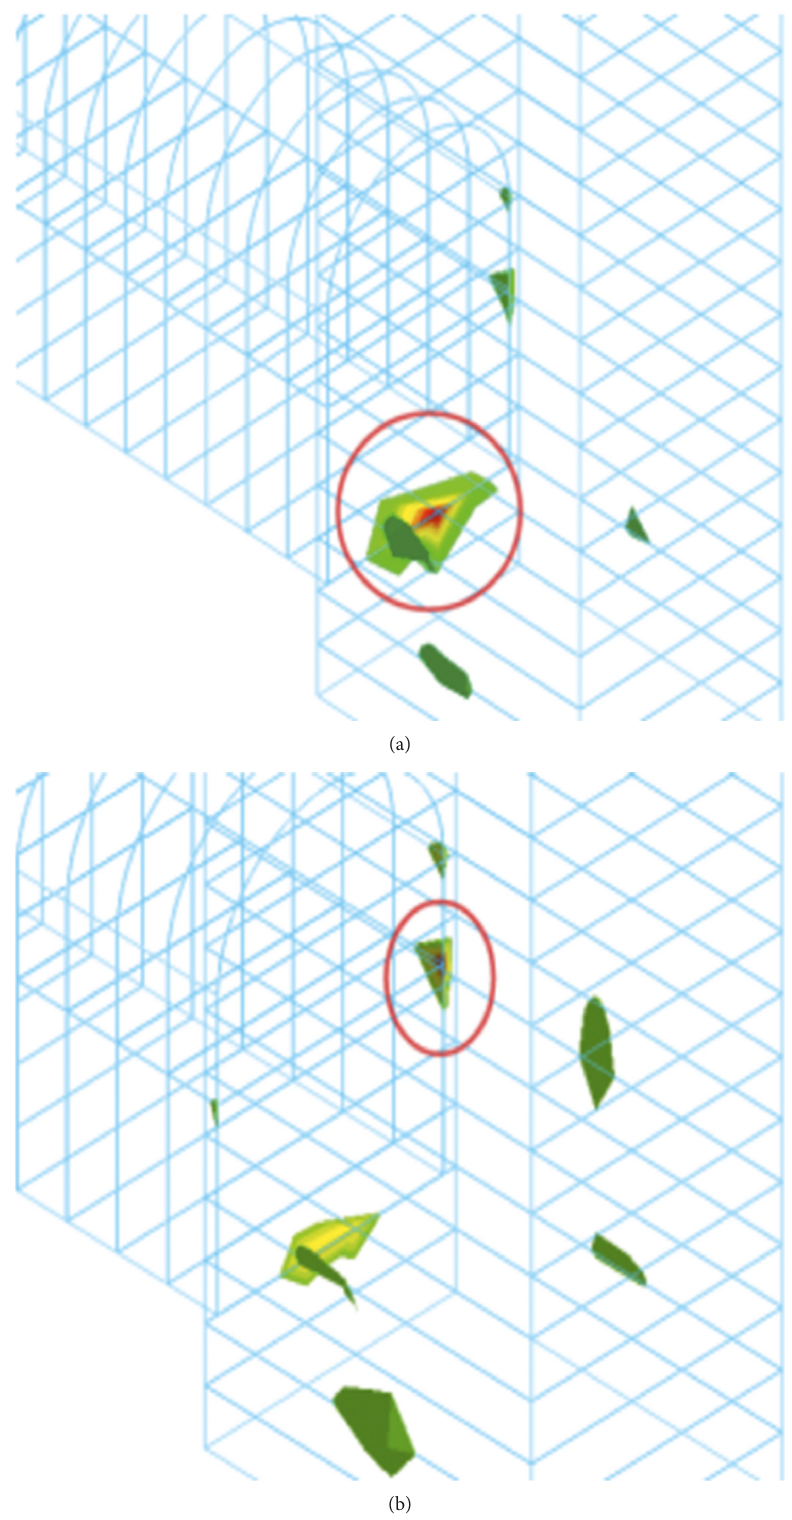
Figure 7: Distribution of maximum plastic deformation. (a) Method 1. (b) Method